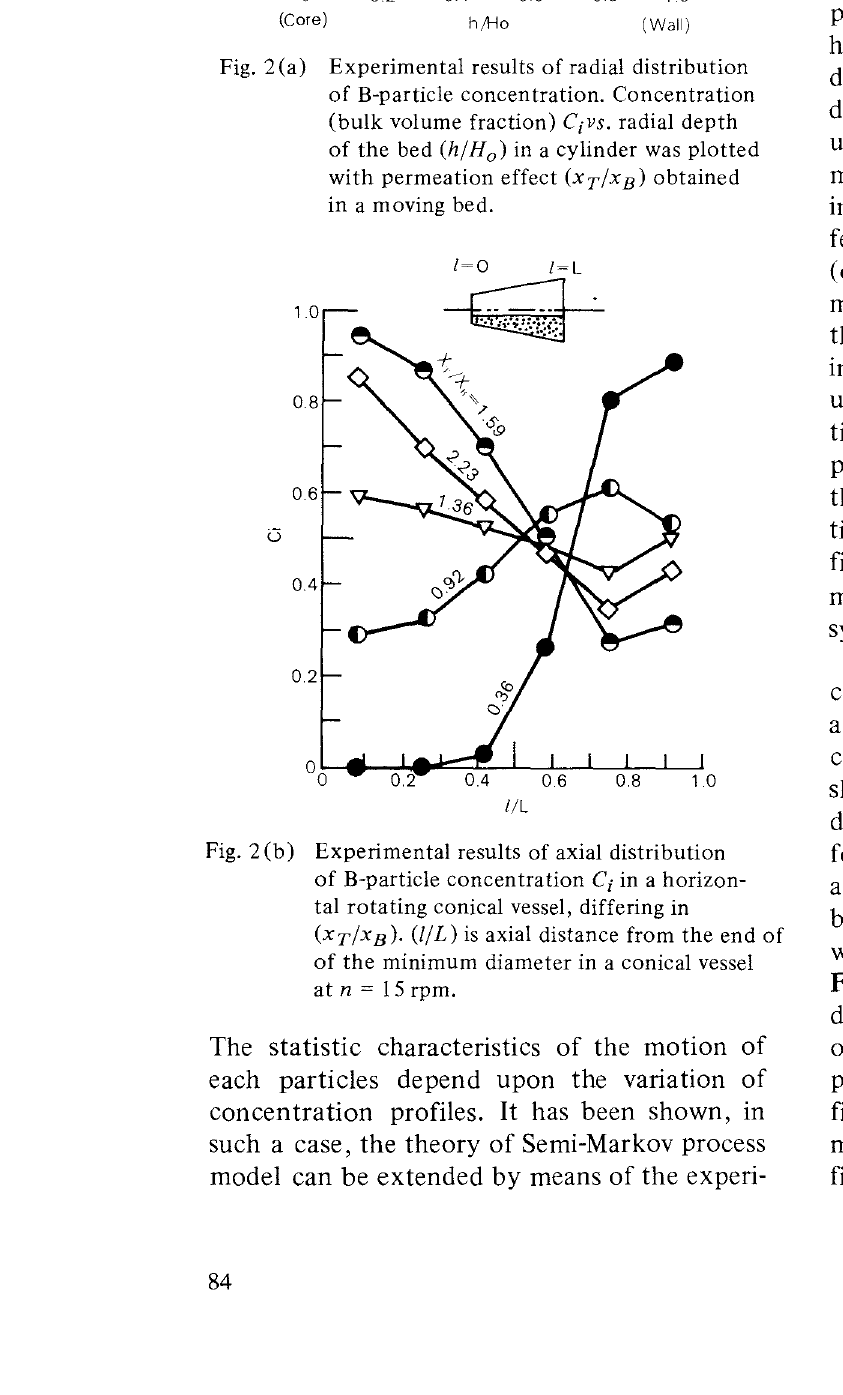
Fig. 2(a) Experimental results of radial distribution of B-particle concentration. Concentration (bulk volume fraction) Civs. radial depth of the bed (h/H in a cylinder was plotted 0 ) with permeation effect (xrfxB) obtained in a moving bed.